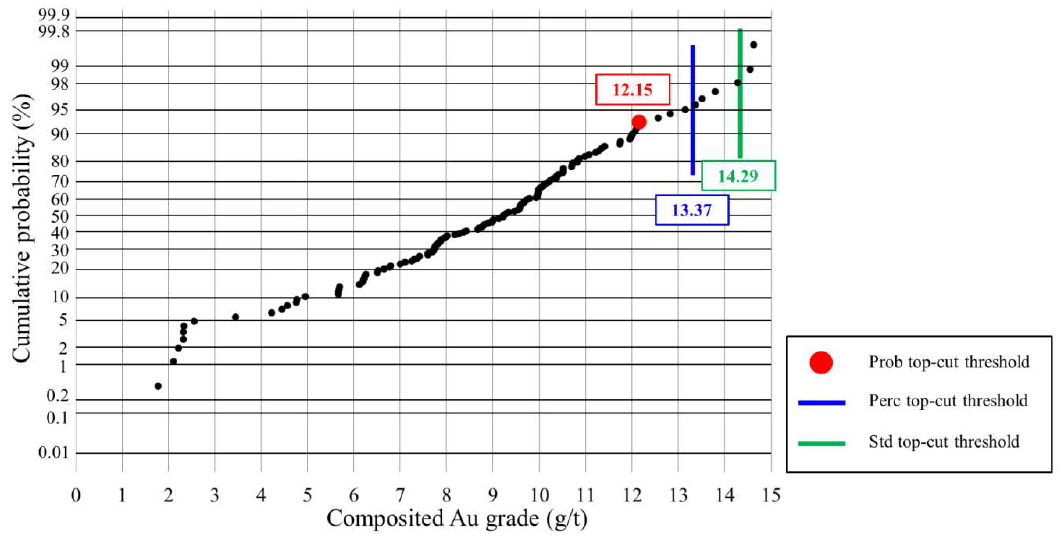
Figure 4. Probability plot of Au grade and threshold values of existing top-cut methods.